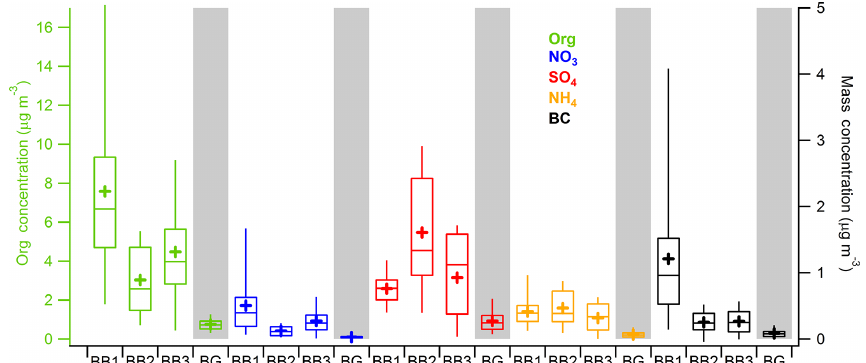
Figure 8. A comparison of the chemical compositions between the three biomass burning events (BB1, BB2 and BB3) and background conditions (BG; highlighted in light gray). The boxes denote the median and the 25th and 75th percentiles, the whiskers represent the 5th and 95th percentiles and the crosses represent mean values. Organic aerosols are represented by the left axis, while other species are represented by the right axis.